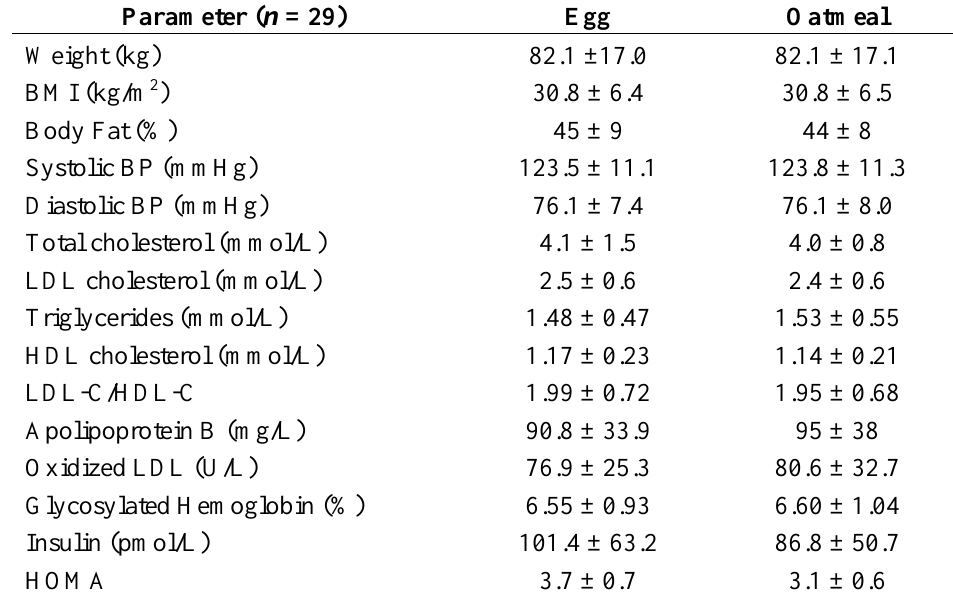
Table 3. Anthropometrics, Blood Pressure (BP), Plasma Lipids, Oxidized LDL, Apolipoprotein B, Glucose, Glycosylated Hemoglobin, Insulin and HOMA after the Egg and Oatmeal Breakfasts *.